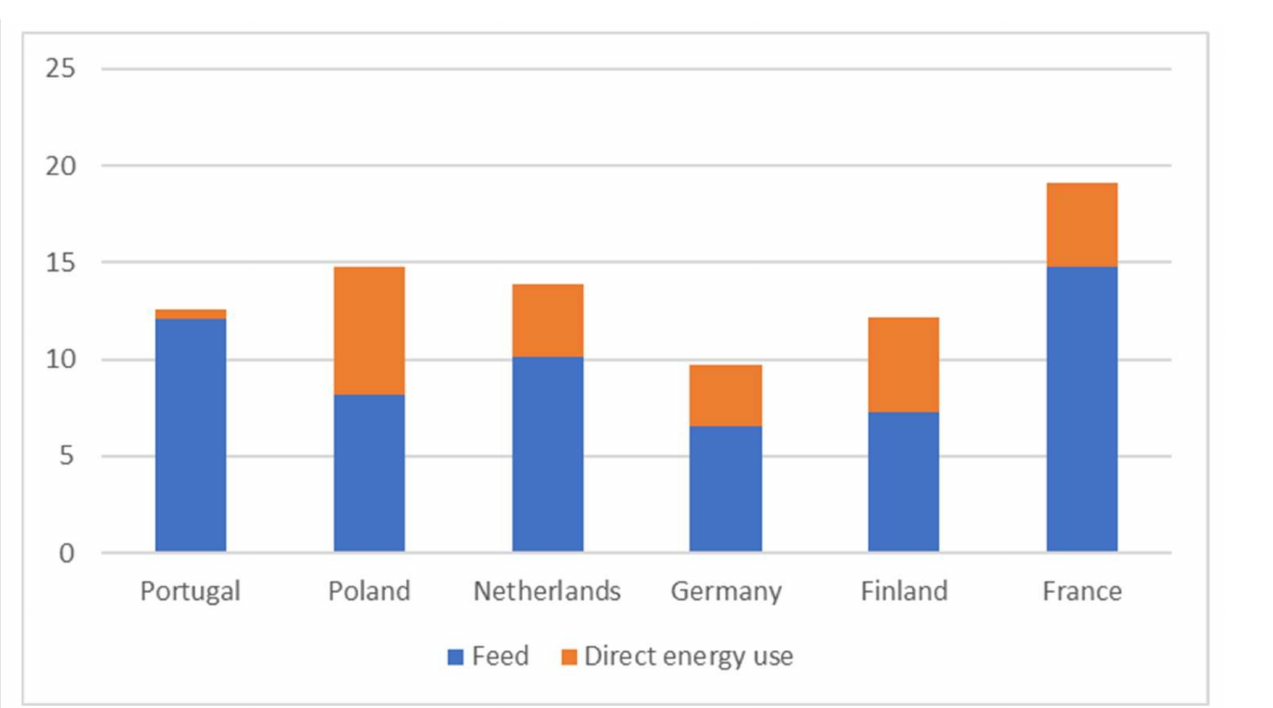
Figure 6. Energy inputs for broiler production MJ/kg (based on [15,21]).